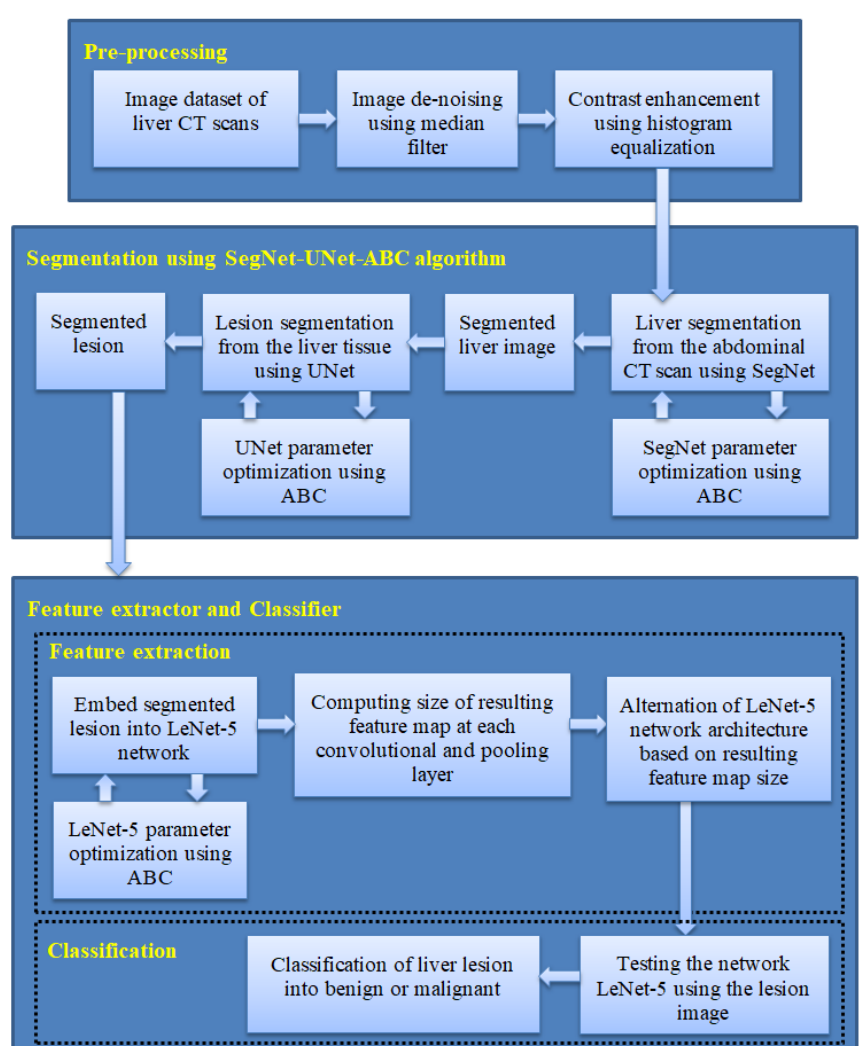
Figure 6. Proposed approach for liver cancer diagnosis, including (1) preprocessing, (2) liver lesion segmentation using the SegNet-UNet-ABC algorithm, and (3) feature extraction and classification of liver lesions using the LeNet-5/ABC algorithm.